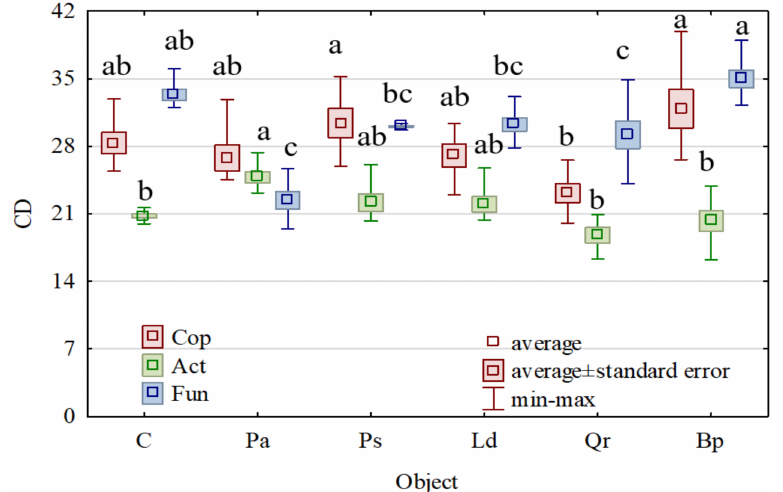
Figure 4. The colony development index (CD) for Cop—copiotrophic bacteria, Act—actinomycetes and Fun—fungi. C—non-afforested land, Pa— Picea abies L., Ps— Pinus sylvestris L., Ld— Larix decidua M., Qr— Quercus robur L., and Bp— Betula pendula L. Homogeneous groups (denoted with letters a–c)